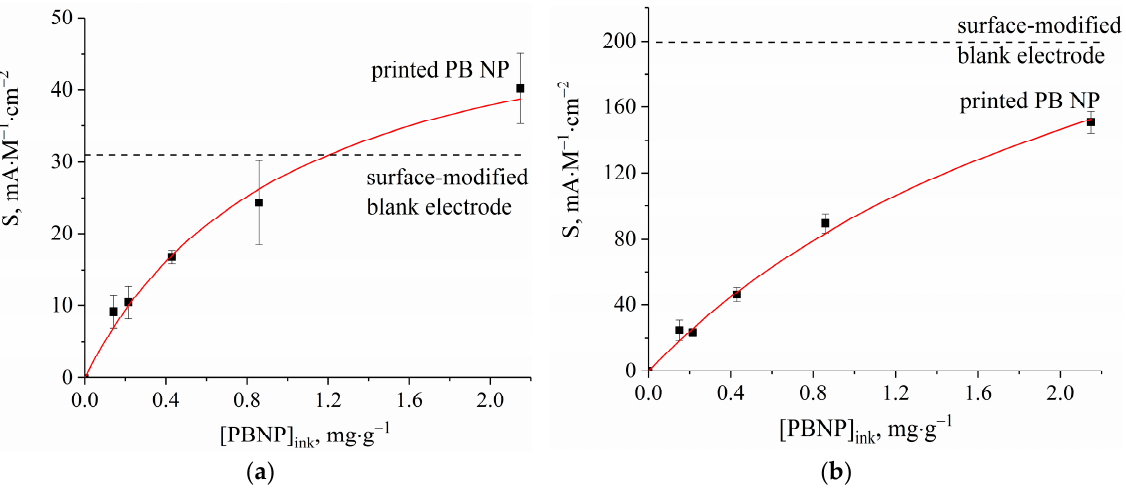
Figure 6. Sensitivity dependance on Prussian blue nanoparticle concentration in carbon/graphite ink for ( a ) glucose and ( b ) lactate biosensors based on printed hydrogen peroxide sensors. Table 1. Analytical performance of (bio)sensors based on printed electrodes.